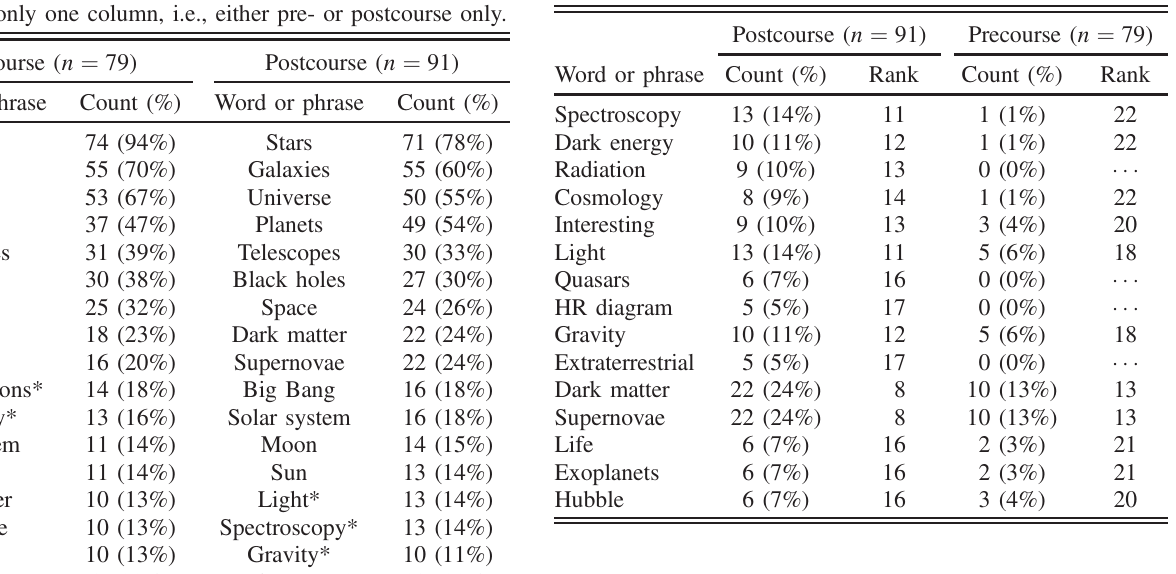
TABLE V. Top 15 words or phrases which students associated with astronomy more prominently postcourse than precourse. The words are ranked by improvements in rank from precourse to postcourse; words with fewer than 5 occurrences both pre- and postcourse are excluded from the